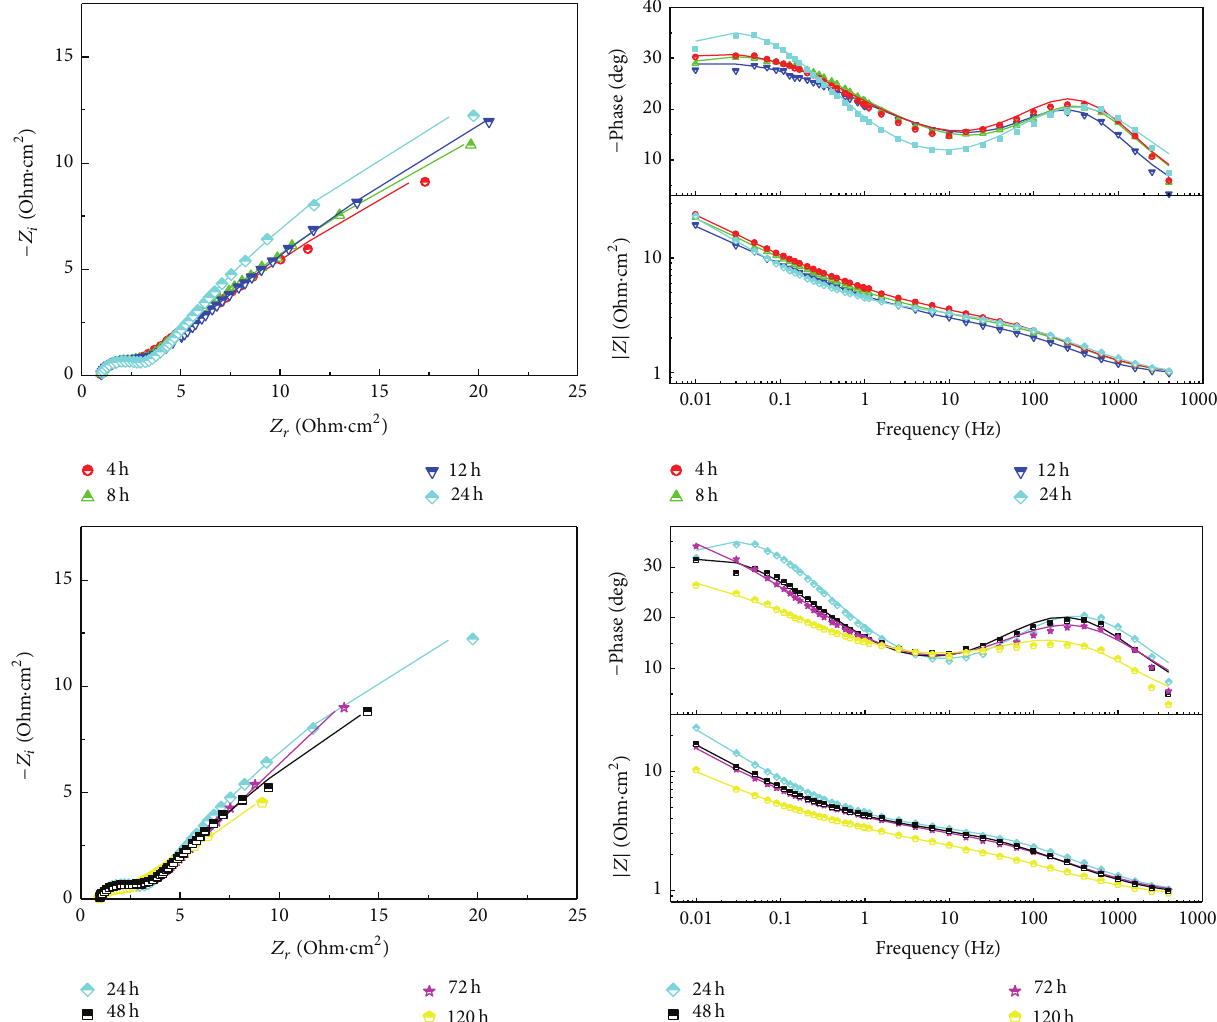
Figure 1: Nyquist and Bode plots of P92 in molten carbonate at 650 ∘ C in air. Scattered points are measured data and lines are simulated data.